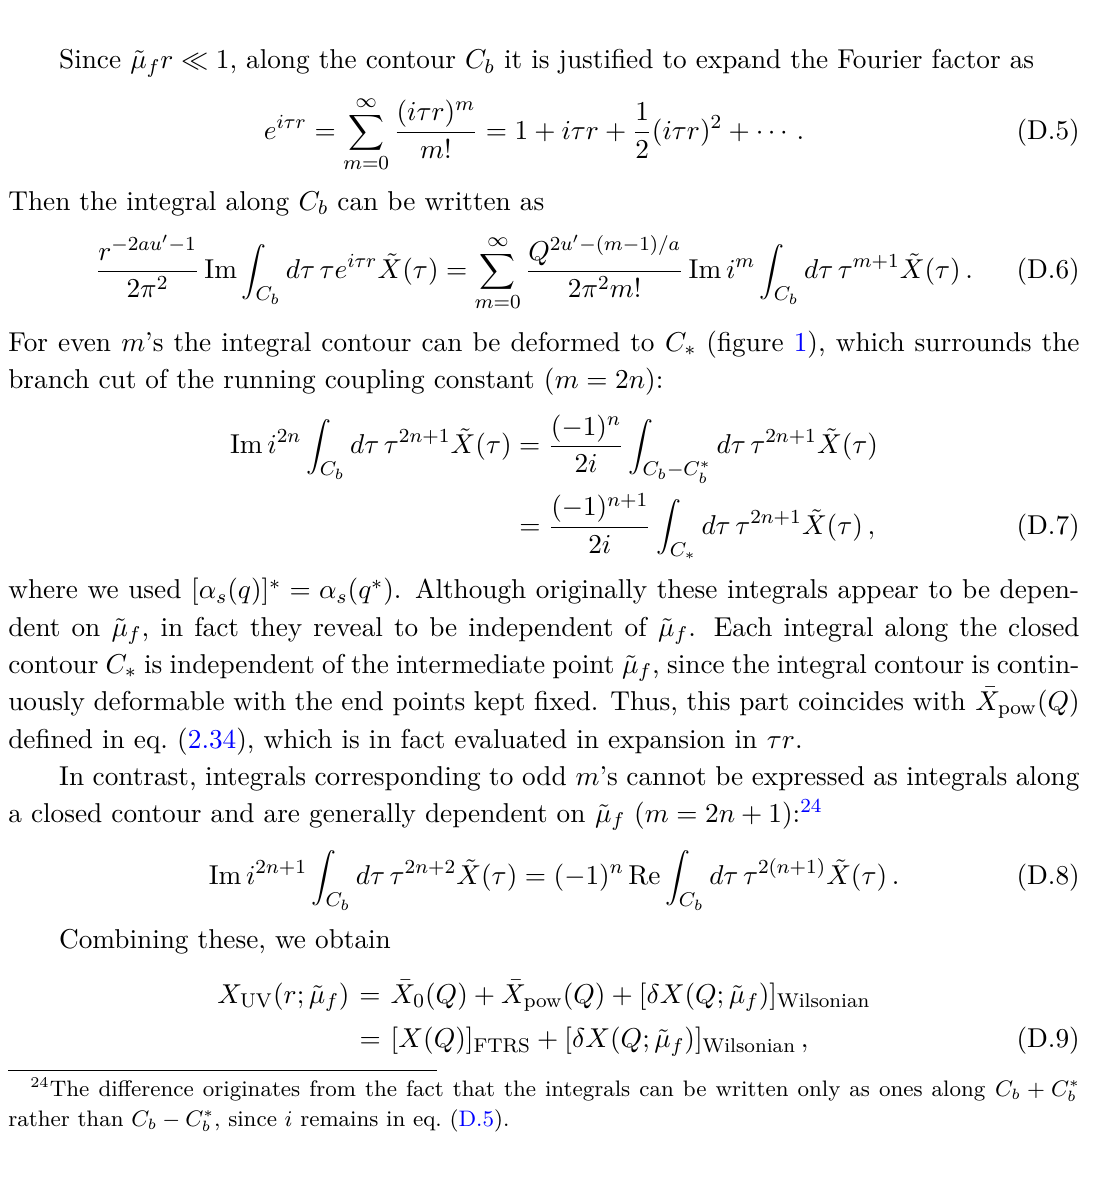
Figure 14 . Integral contours in the complex τ -plane shown by blue lines. The branch cut of the running coupling constant is also